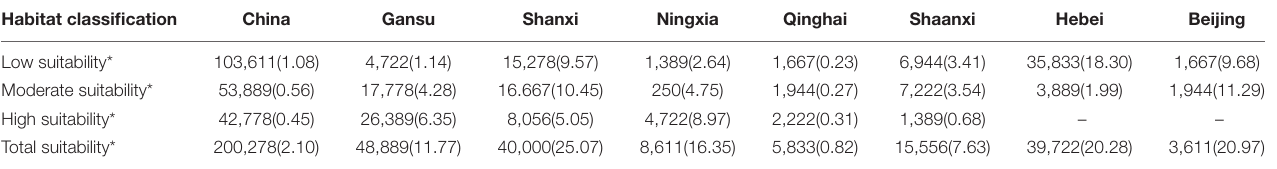
TABLE 2 | Overlapping area (km 2 ) and percentage (%) of B. pyrosoma distribution area in China and seven provinces. Habitat classification